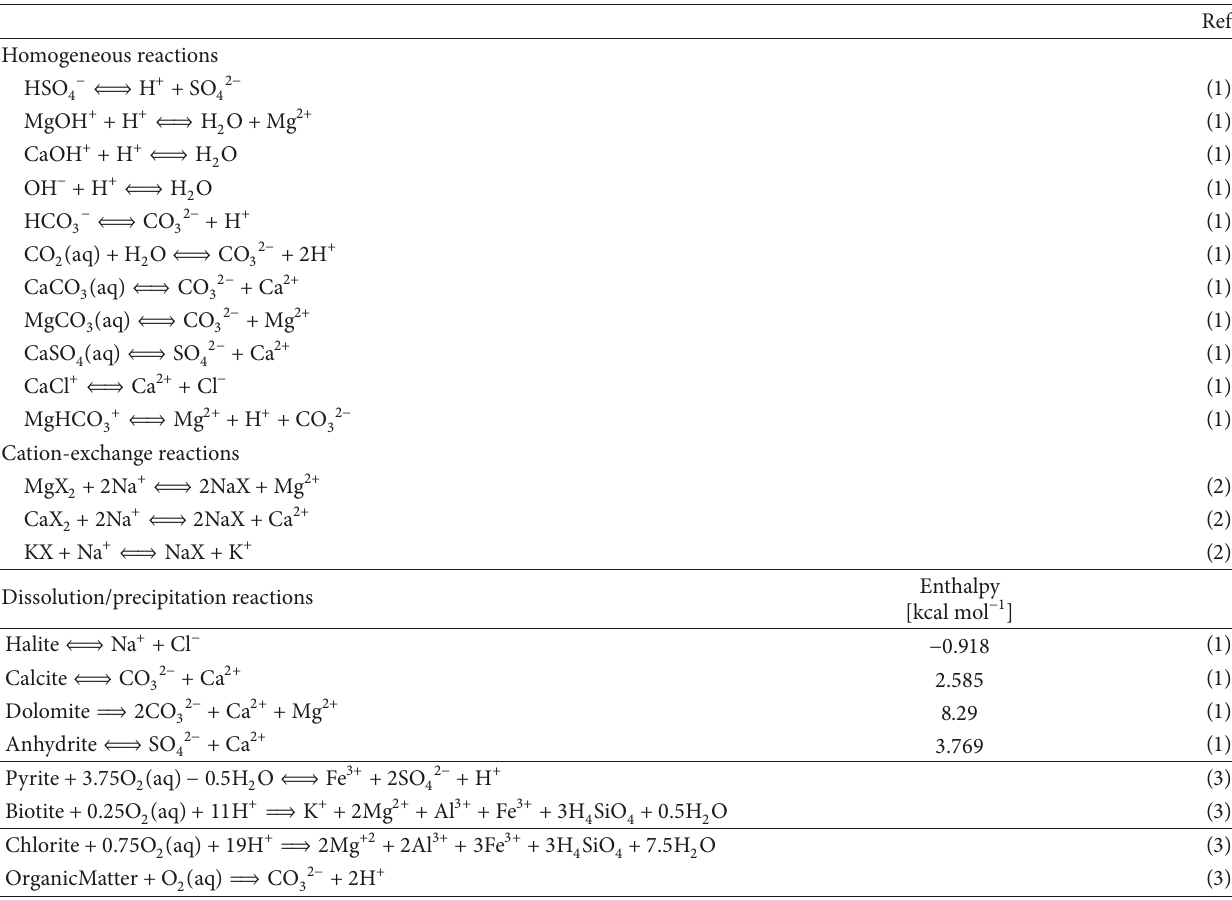
Table 1: Geochemical reactions considered in the illustrative sedimentary basin example.